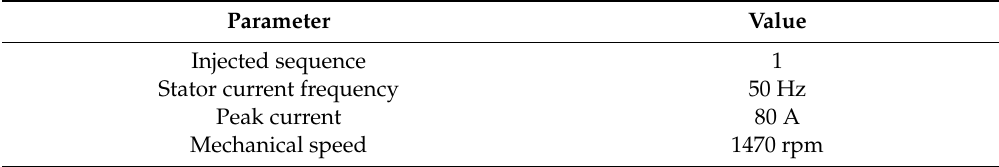
Table 3. Simulation parameters for the three ‐ phase induction machine (IM).